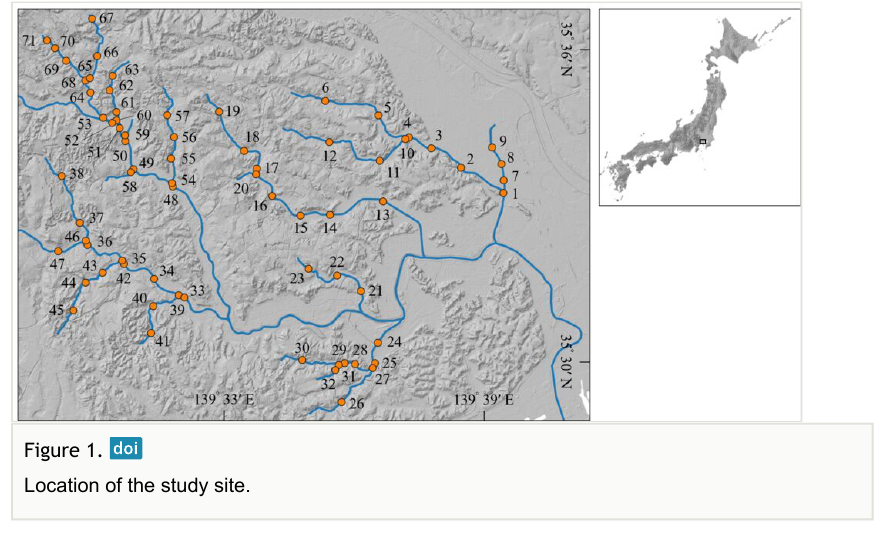
Figure 1. Location of the study site.